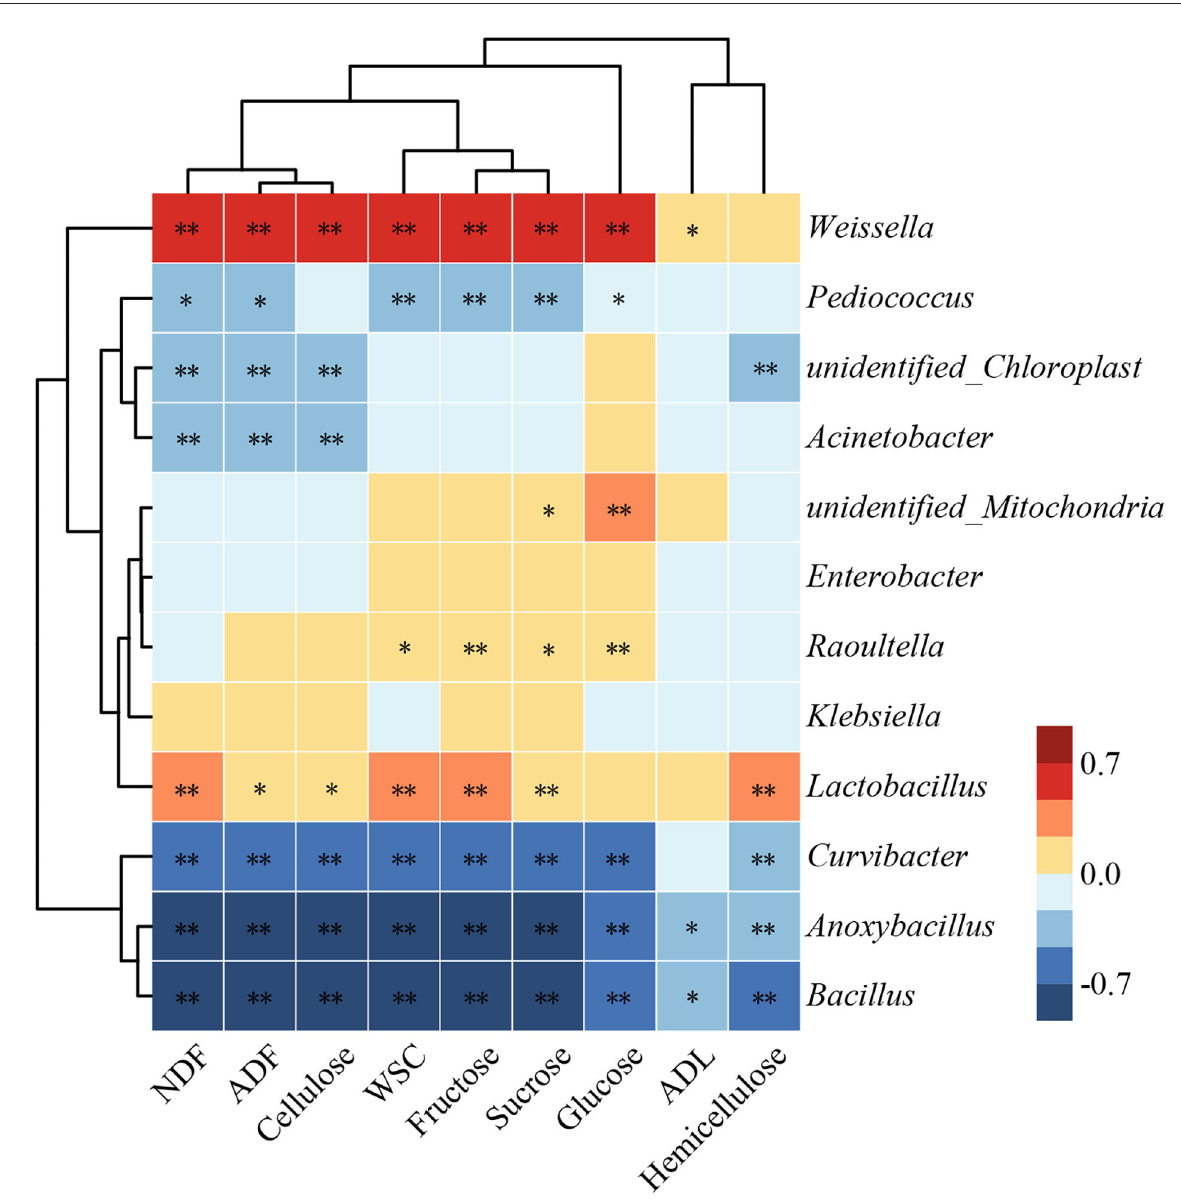
FIGURE5 Heat map showing the correlations of dominant bacteria with lignocellulose and fermentable carbohydrates of hybrid elephant grass during ensiling. * and ** represent P < 0.05 and P < 0.01, respectively. NDF, neutral detergent fiber; ADF, acid detergent fiber; ADL, acid detergent lignin; WSC, water-soluble